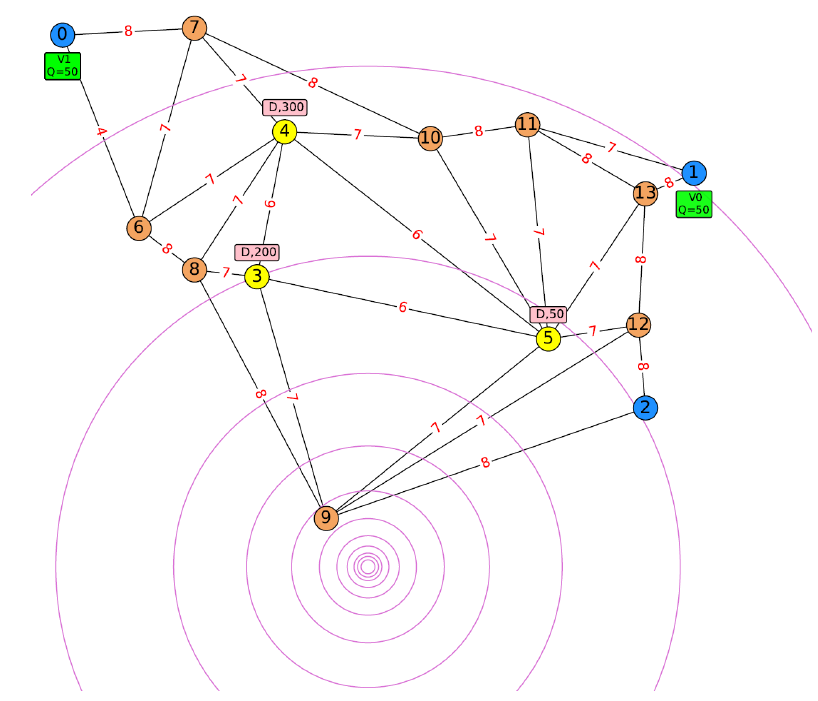
Figure A1. Road network for instance D3N8S3